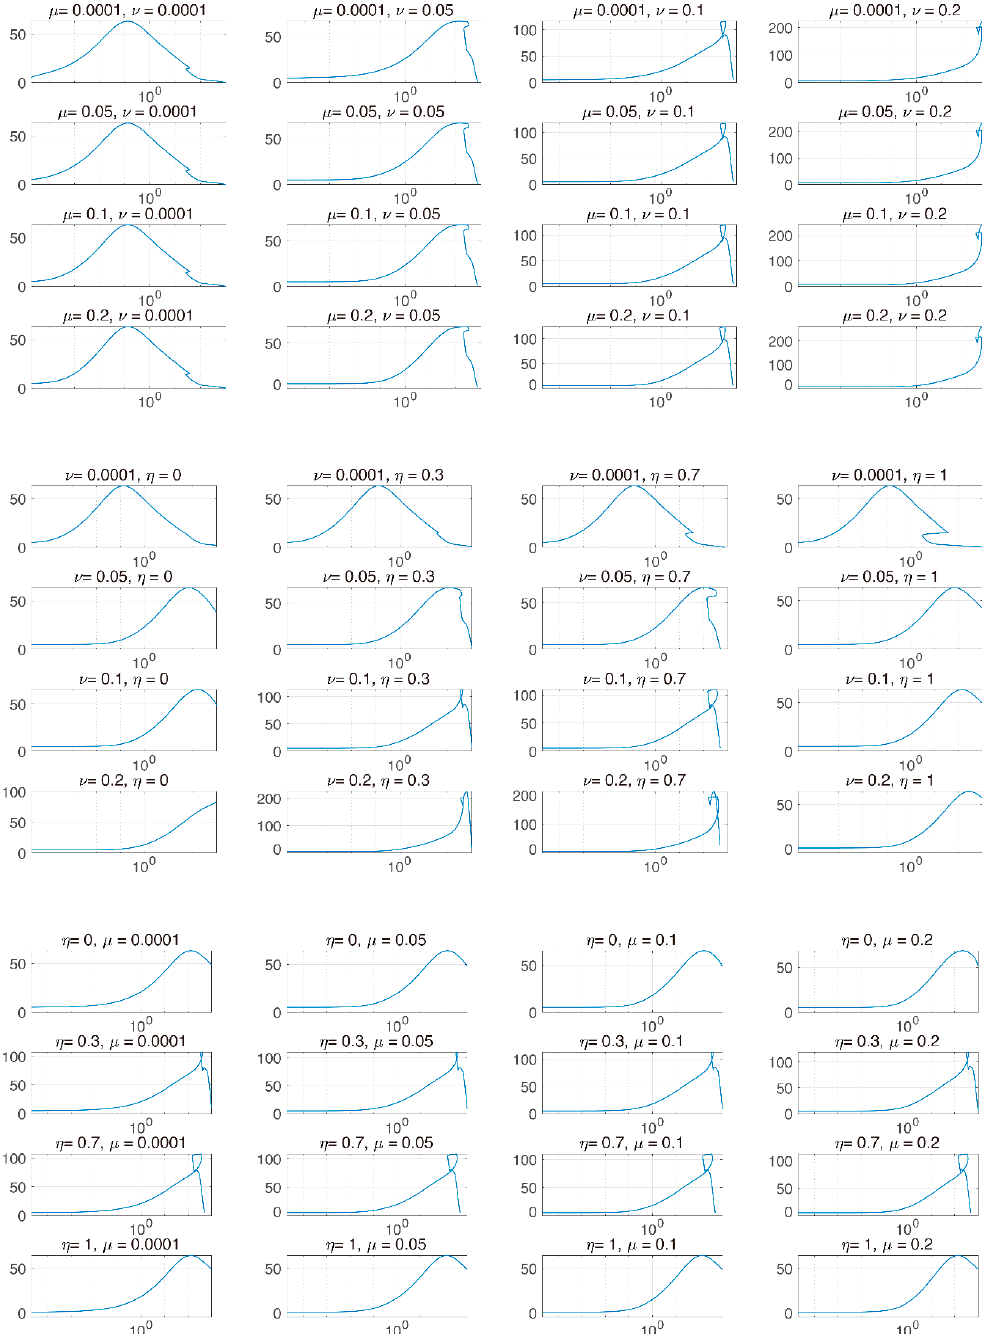
Figure 4. The x and y axes represent the sum of PD-1 and PD-L1 and tumor size, respectively. The x axis is plotted on a logarithmic scale. Each graph indicates the two parameters that are varied. µ , ν , and η are varied from [1 × 10 − 4 , 0.2], [1 × 10 − 4 , 0.2], and [0, 1], respectively. After beginning combination therapy, the sum of PD-1 and PD-L1 is not positively proportional to tumor size.